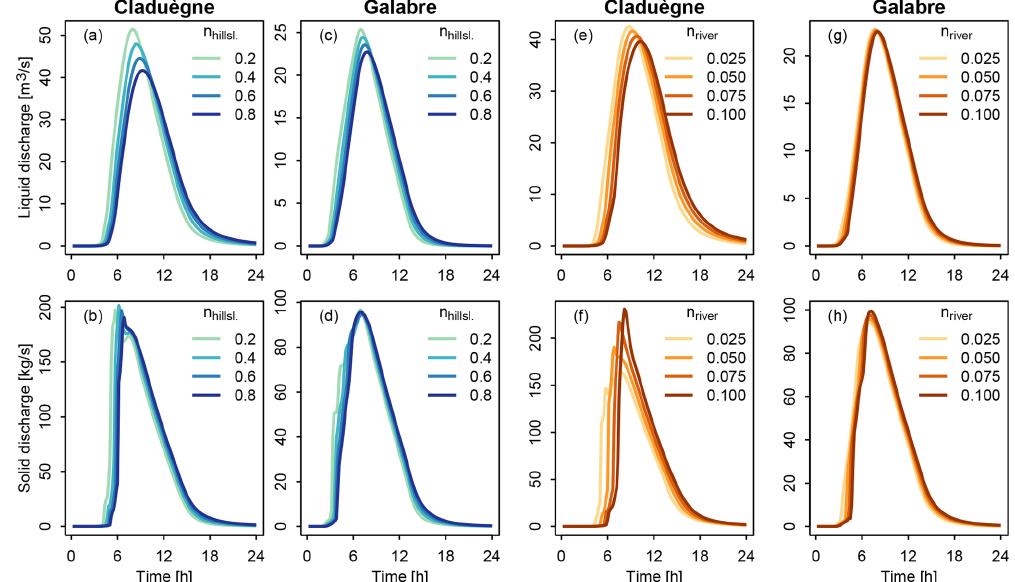
Figure 8. Sensitivity of modeled hydrographs (a, c, e, g) and sedigraphs (b, d, f, h) to changing Manning’s roughness parameter on the hillslopes (a–d) and in the river network (e–h) . For panels (a–d) n river was fixed to 0.05. For panels (e–h) n hillsl. was fixed to